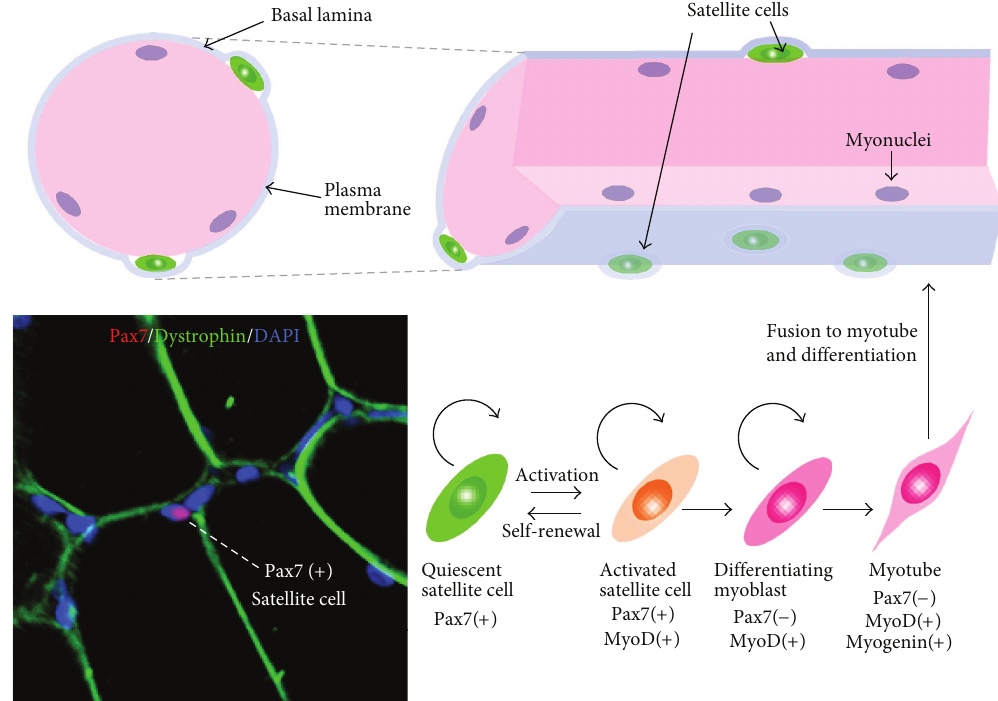
Figure 1: The self-renewal, activation, and differentiation of satellite cells in adult skeletal muscle. Satellite cells reside adjacent to the plasma membrane under the basal lamina on the surface of the myofiber. The nuclei of myofiber (myonuclei) are positioned at the periphery of the cell. Satellite cells are activated upon receiving various external stimuli and differentiate together with the upregulation of MyoD. Quiescent and activated satellite cells express a characteristic marker, Pax7. Immunohistochemical detection of Pax7 (red), dystrophin (green) and DAPI (blue) of adult rat skeletal muscle is shown (left